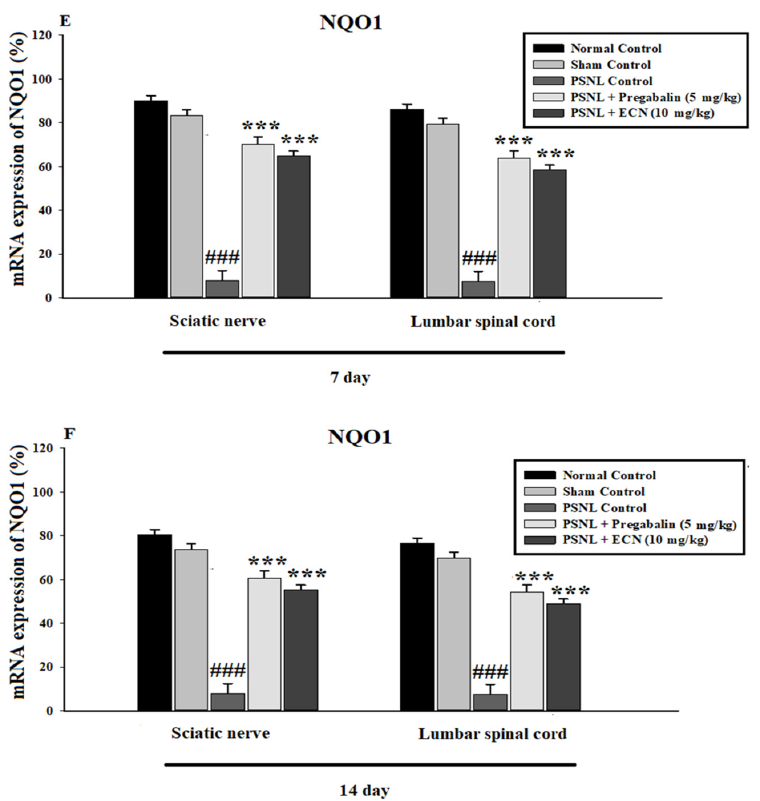
Figure 9. Effects of ECN (10 mg/kg, i.p.) on the oxidative stress markers in the spinal cord and sciatic nerve tissue using qtRT-PCR. ( A ) ECN (10 mg/kg, i.p.) treatment significantly enhanced the mRNA expression levels of Nrf2 in the sciatic nerve and spinal cord tissue on day 7 post-PSNL surgery. ( B ) ECN (10 mg/kg, i.p) treatment significantly enhanced the mRNA expression levels of Nrf2 in sciatic nerve and spinal cord tissue on day 14 post-PSNL surgery. ( C ) ECN (10 mg/kg, i.p) treatment significantly enhanced the mRNA expression levels of HO-1 in sciatic nerve and spinal cord tissue on day 7 post-PSNL surgery. ( D ) ECN (10 mg/kg, i.p) treatment significantly enhanced the mRNA expression levels of HO-1 in the sciatic nerve and spinal cord tissue on day 14 post-PSNL surgery. ( E ) ECN (10 mg/kg, i.p) treatment significantly enhanced the mRNA expression levels of NQO1 in sciatic nerve and spinal cord tissue on day 7 post-PSNL surgery. ( F ) ECN (10 mg/kg, i.p.) treatment significantly enhanced the mRNA expression levels of NQO1 in sciatic nerve and spinal cord tissue on day 14 post-PSNL surgery. The data is presented as the mean (n = 3) ± S.D. Different letters meant statistically significant differences: (***) p < 0.001 indicate significant differences from the PSNL control group. (###) indicate significant differences from the normal control group. *** p < 0.001 (two-way ANOVA followed by Dunnett’s